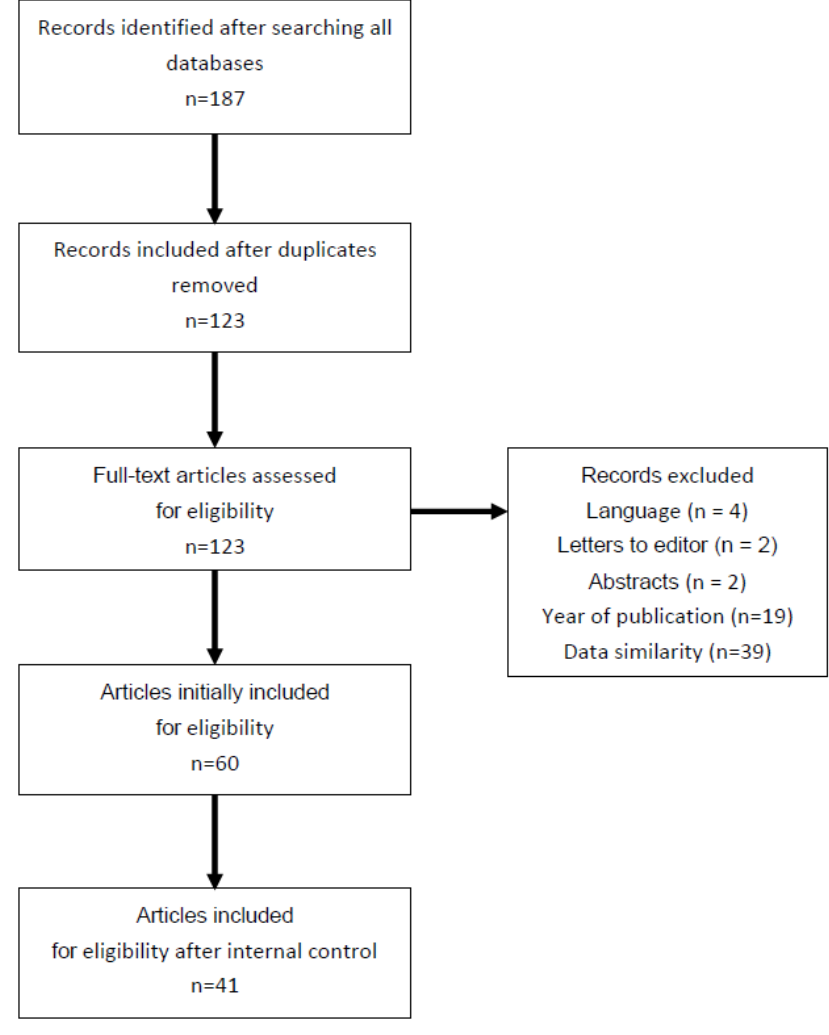
Figure 1. Flow chart of the articles selection process.